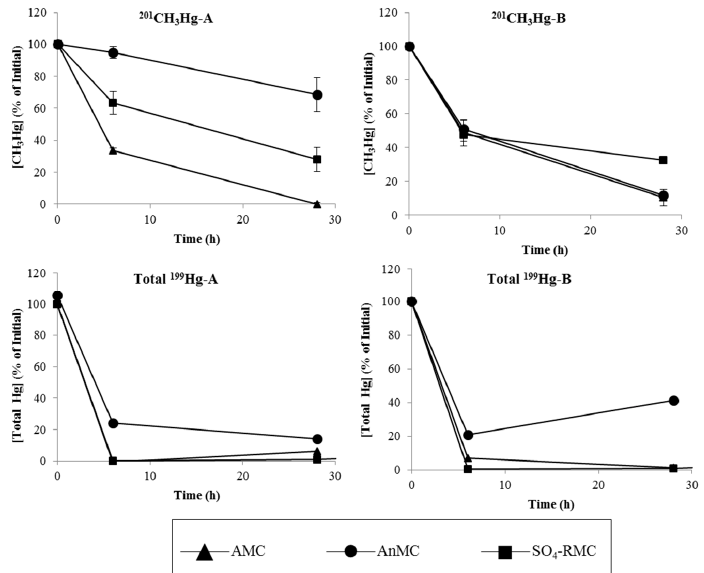
Figure 2. CH 3 201 Hg and total (all forms) 199 Hg content in supernatant samples after 6 and 28 h of incubation of three different microbial communities of aerobic microbes (AMC), anaerobic microbes (AnMC), and sulphate-reducing microbes (SO 4 -RMC) after initial addition of 2.05 ng/mL of CH 3 201 Hg + and 105.6 ng/mL of 199 Hg 2+ . The three microbial communities were isolated from two areas of the Tagus Estuary in Cala do Norte ( A ) and Barreiro ( B